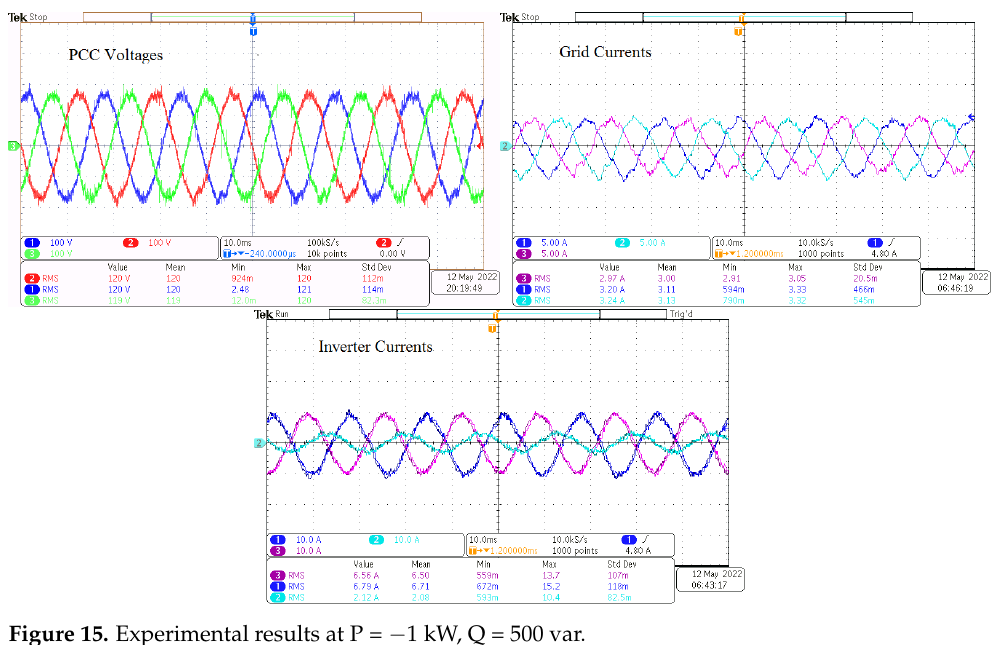
Figure 15. Experimental results at P = − 1 kW, Q = 500 var.